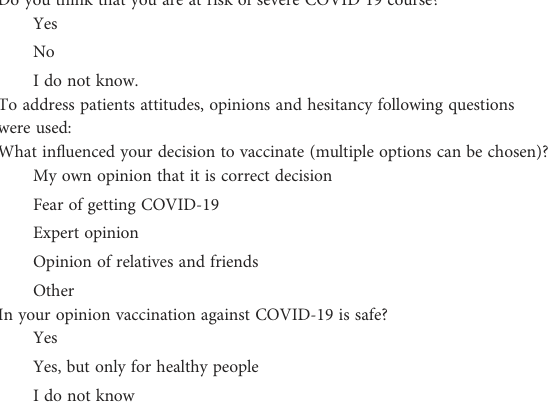
TABLE 1 Representative questions from the Vaccine Hesitancy Questionnaire. Fear of SARS-Cov-2 infection was searched using the